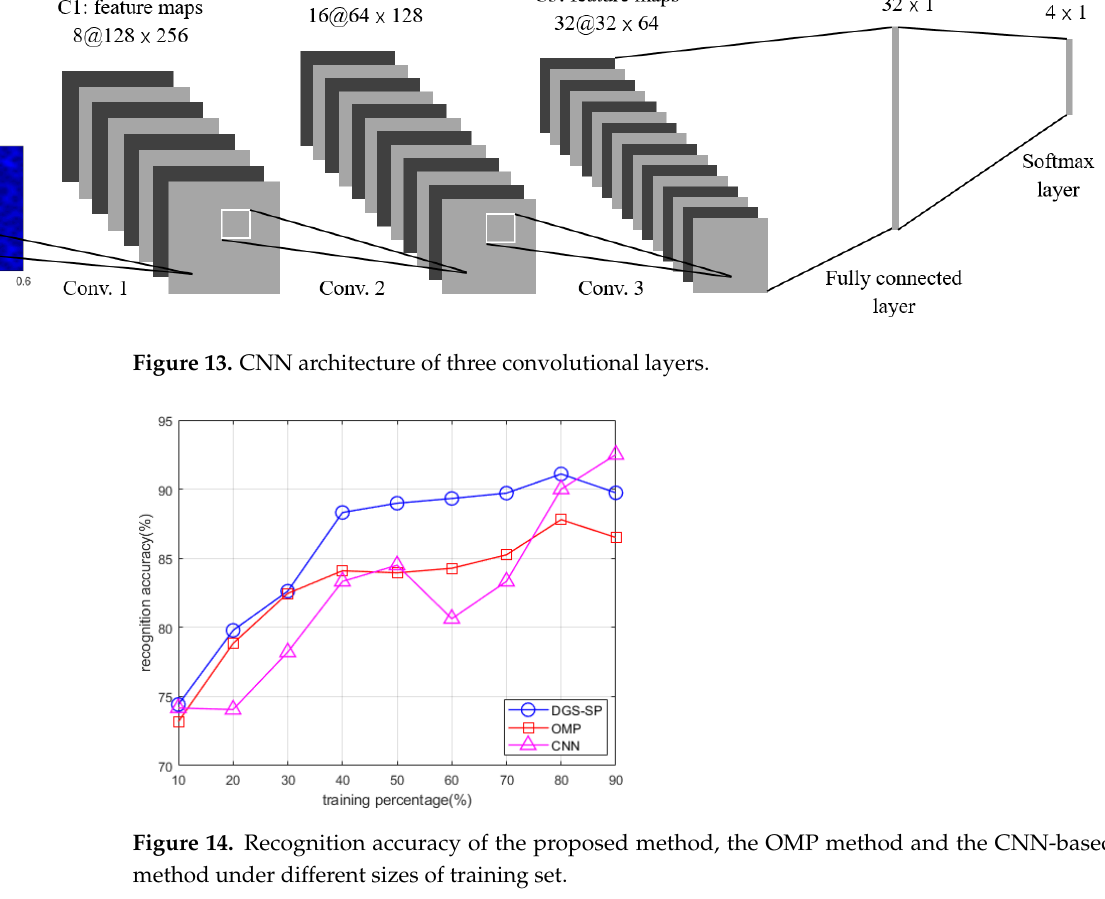
Figure 14. Recognition accuracy of the proposed method, the OMP method and the CNN-based method under different sizes of training set.